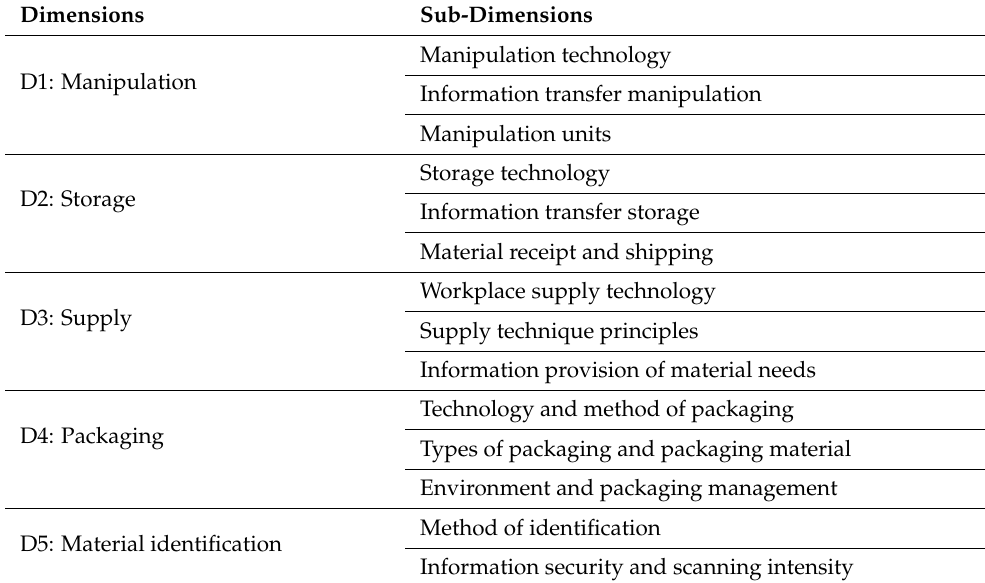
Table 4. Distribution of